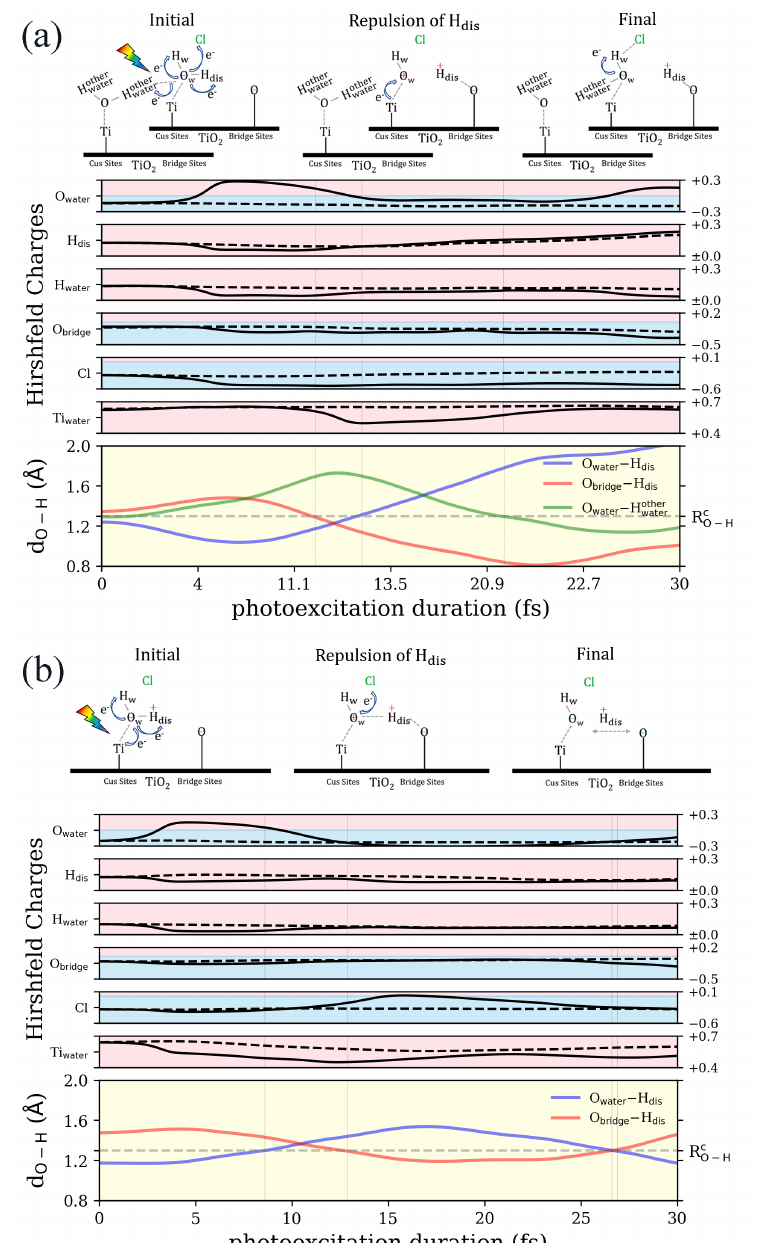
Figure 5. Time evolved O-H bond length (d O − H ), Hirshfeld charges (q H ), and a schematic represen- tation of charge transfer during the photoexcitation duration. Panel ( a ) displays the reaction of full dissociation, while panel ( b ) shows the oscillation reaction of dissociated hydrogen, which is the same as shown in Figure 3 (light yellow span). The bottom panels present the time-dependent d O − H along the reaction, and the legends are the same as those in Figure 3a,b, respectively. The middle panels show the time evolution of q H for different atoms: the titanium nearest to H 2 O Cl (Ti water ), chlorine (Cl), oxygen of bridge site (O bridge ), the hydrogen of H 2 O Cl (H water ), dissociated hydrogen of H 2 O Cl (H dis ), and oxygen of H 2 O Cl (O water ), respectively. On the panels of q H , the black solid lines (dashed lines) are the q H of excited states (ground states). The light red (light blue) span is the q H above (below) zero. The top panels show two illustrations of the bond networks of H 2 O Cl and the charge transfer on the surface during the reaction. The red cross represents a localized positive q H , while the blue minus sign indicates a localized negative q H . The time instants marked in Figure 4 are indicated within the vertical gray-dotted lines in the illustrations of d O − H and q H